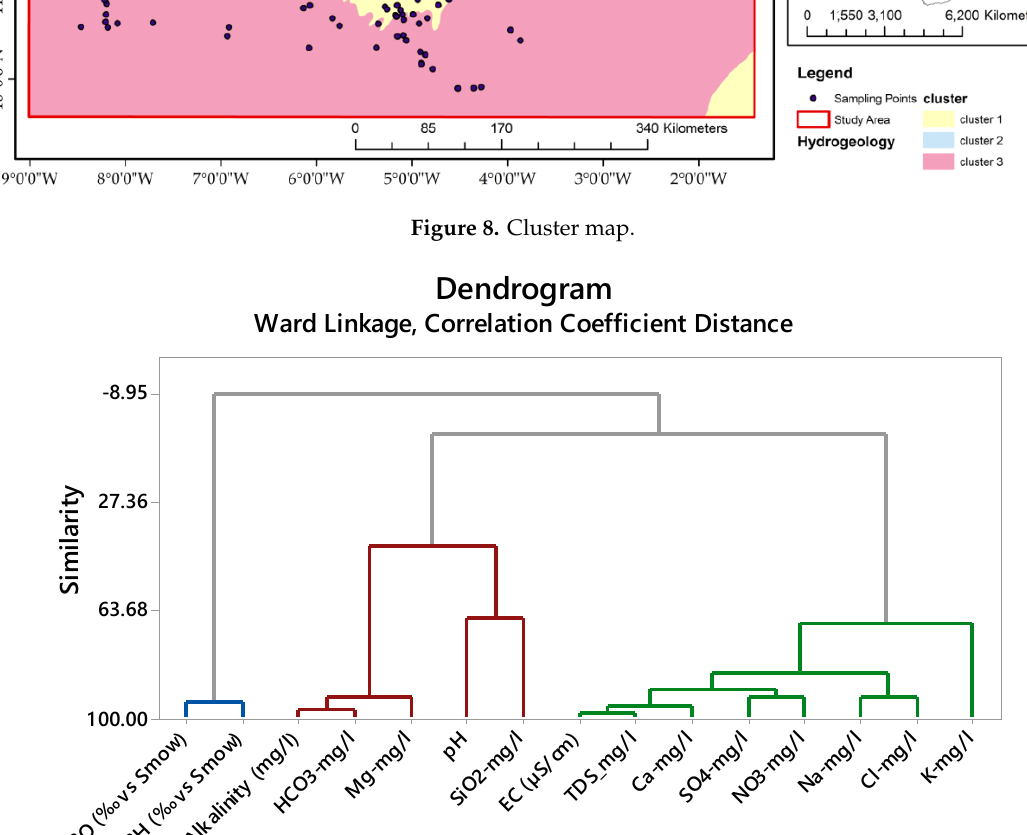
Figure 8. Cluster map.